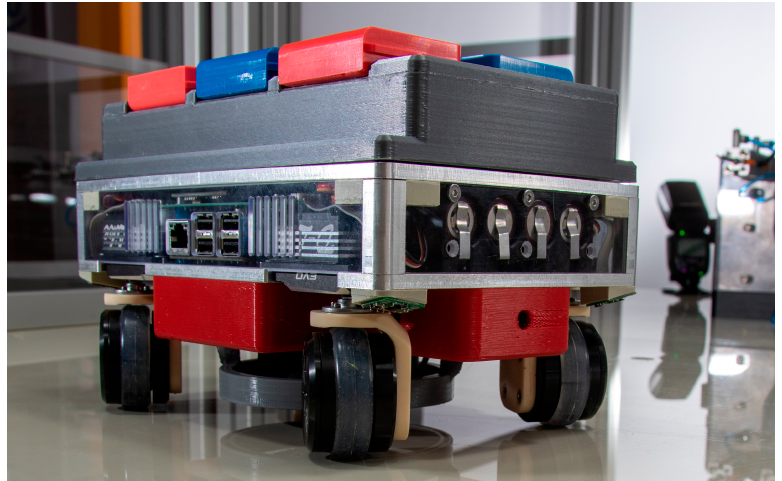
Figure 1. Mobile robot in the real world.